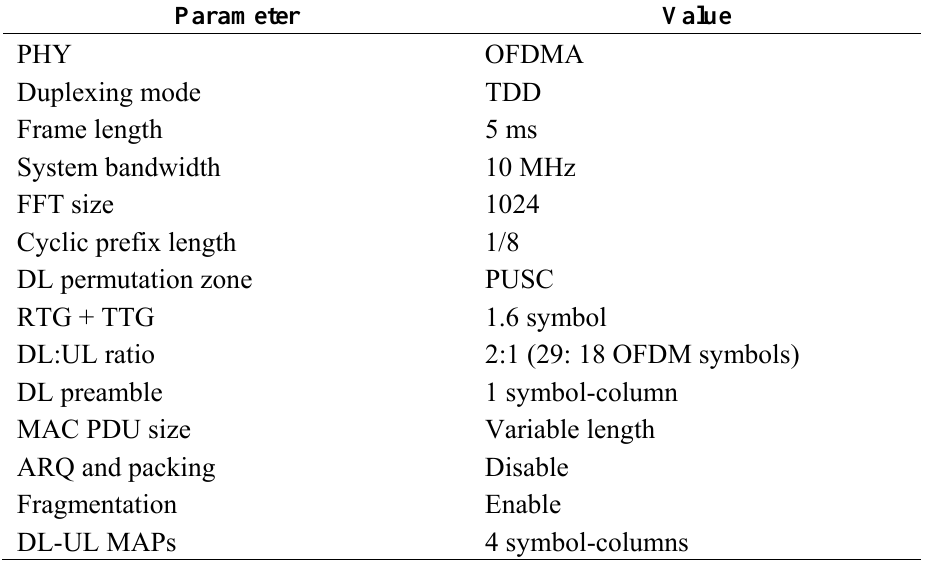
Table 3. Performance Evaluation Parameters [2,5].